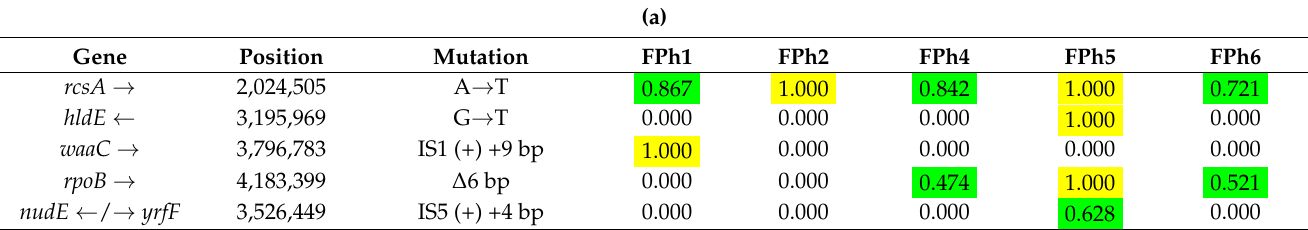
Table 5. ( a ) Position of selective sweeps (yellow) and significant polymorphisms (green) in iron (III)/phage-resistant populations at day 35. ( b ) Annotation of genes mutated (red-nucleotides changed) in iron (III)/phage-resistant populations at day 35. Selective sweep is determined by an increase in frequency of a de-novo mutation to 1.000. A significant polymorphism is determined by an increase in frequency of a de-novo mutation between 0.500 to